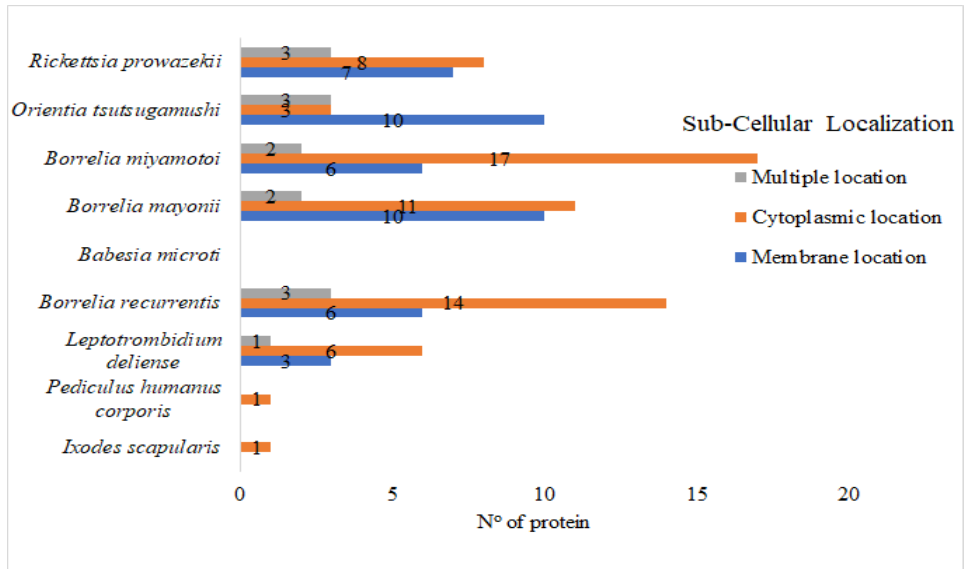
Figure 3. Cellular localization of the essential protein in lice, acari, and their associated pathogens.